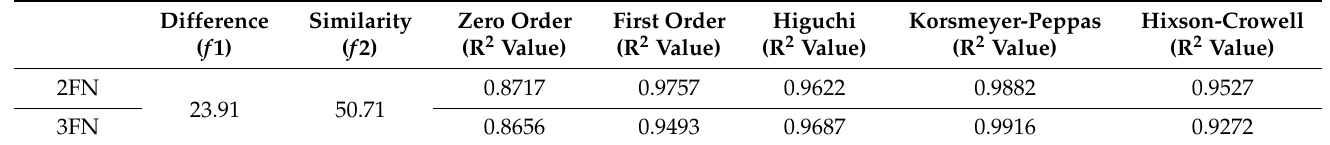
Figure 6. Dissolution profiles of nitrofurantoin from 2FN and 3FN over 3 h. The cumulative release of nitrofurantoin (%) was sampled in 15 min intervals to a maximum of 180 min and quantified by HPLC. Data are expressed as Mean ± SD, n = 3, * p < 0.05. Table 4. Nitrofurantoin dissolution profile modelling and comparison of 2FN and 3FN (difference ( f 1) and similarity ( f 2)).